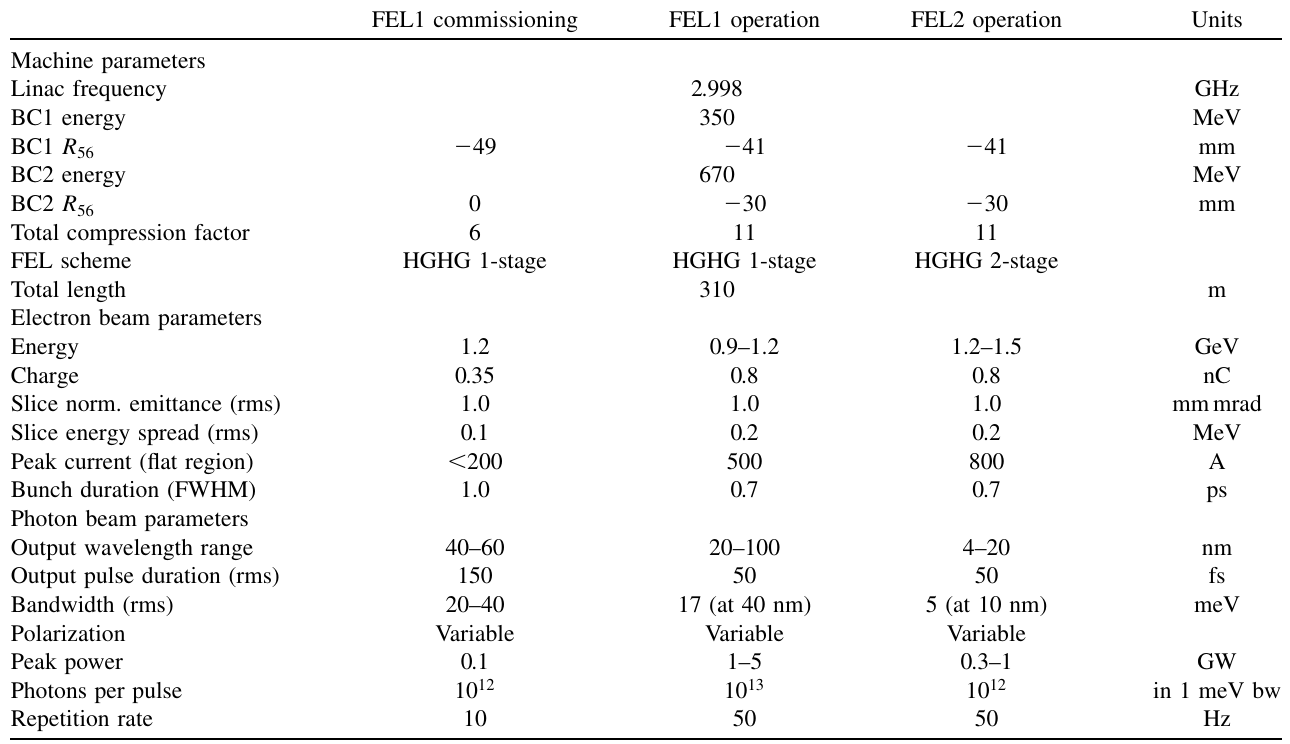
TABLE I. FERMI@Elettra main parameters and